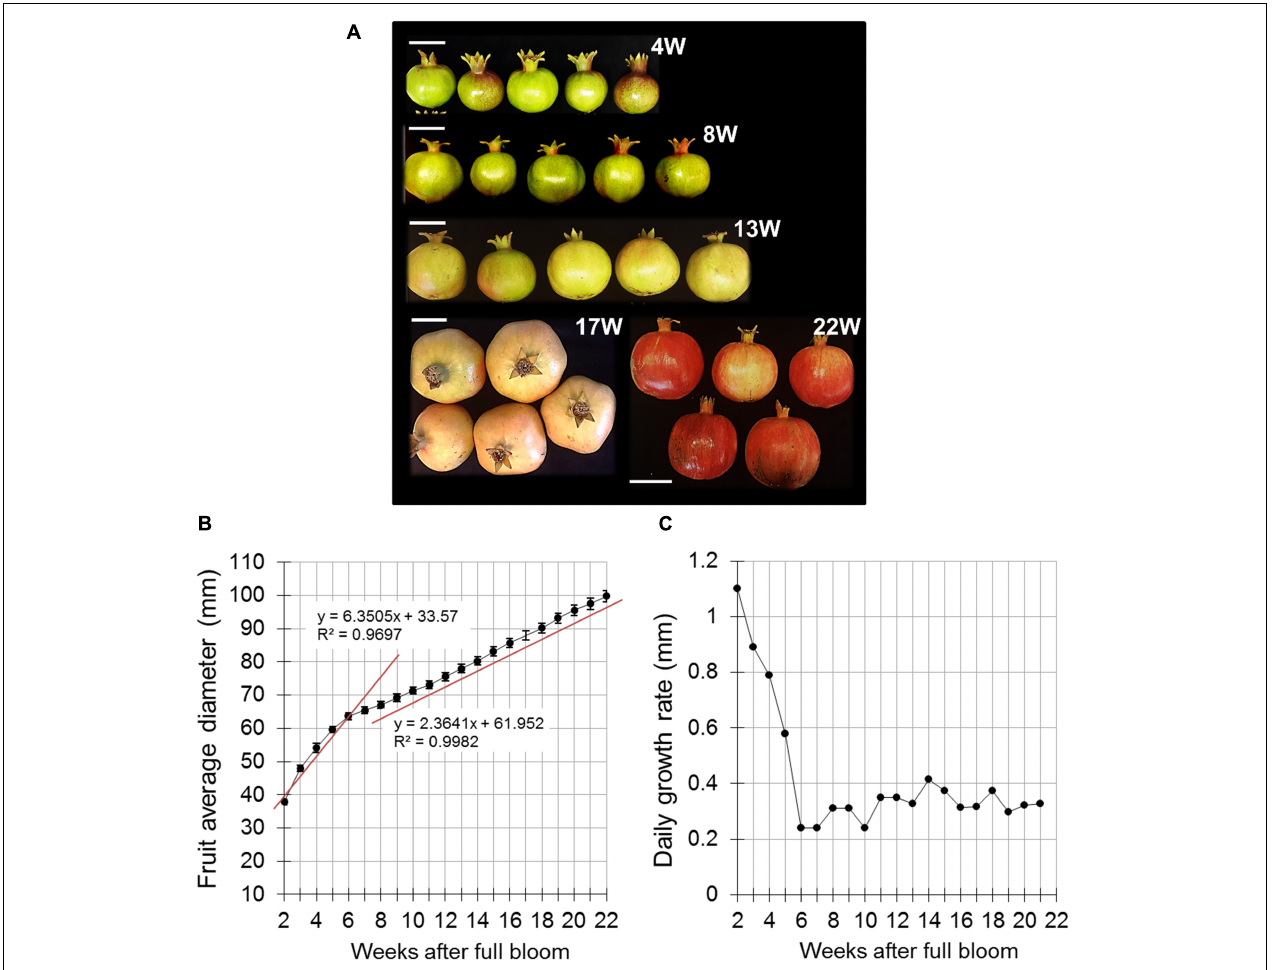
FIGURE 1 | Pomegranate fruit size and growth rate during fruit development in 2014. (A) Presentation of fruit developmental stages indicated as weeks after full bloom (W). Bar = 5 cm. (B) Fruit diameter was measured manually using a caliper. Data represent an average of 20 fruit with ± SE. Trend lines with R 2 -value were added separately to the first and second growth phases (4–6 and 7–22 weeks after full bloom, respectively). (C) Daily growth rate was calculated based on the data presented in (B)